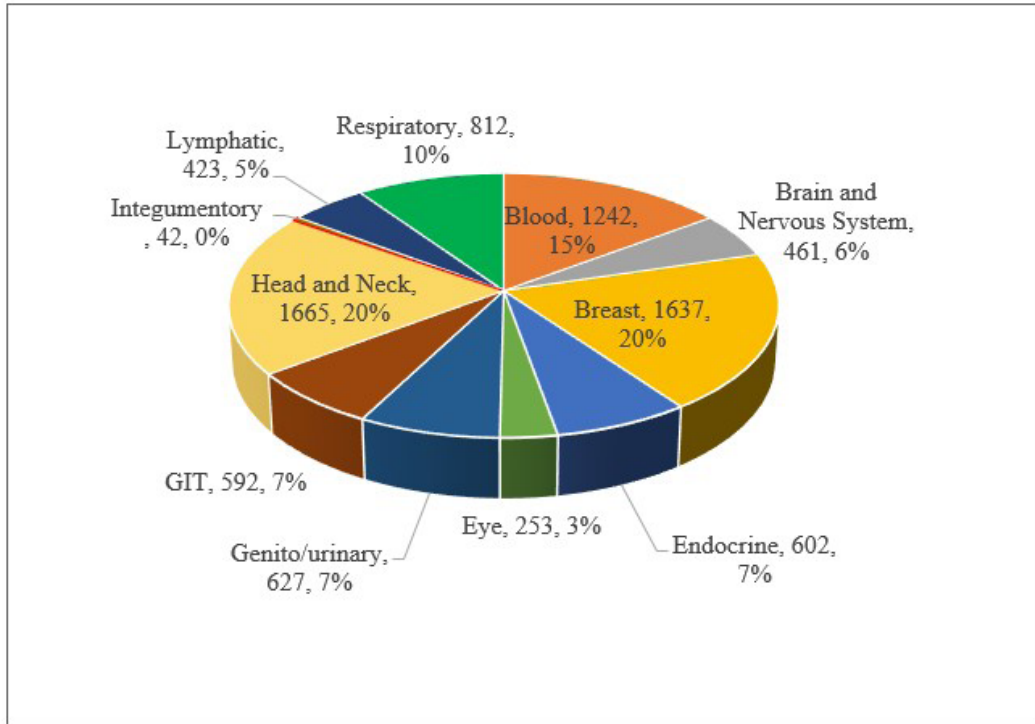
Figure 1 - Types of cancer and no of cases with percentage distribution.